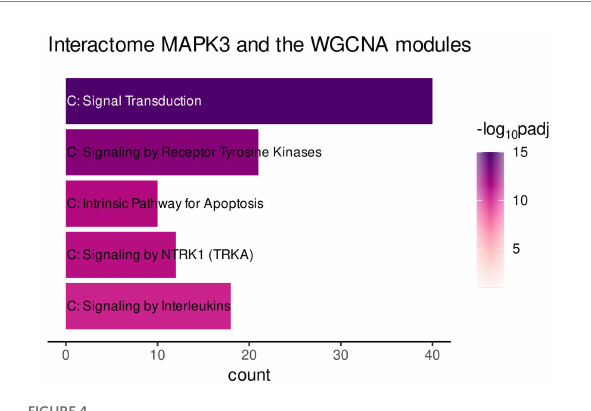
FIGURE 4 Gene functional enrichment of the MAPK3 interactome associated with genes of the turquoise, red, and greenyellow module. Significance values are